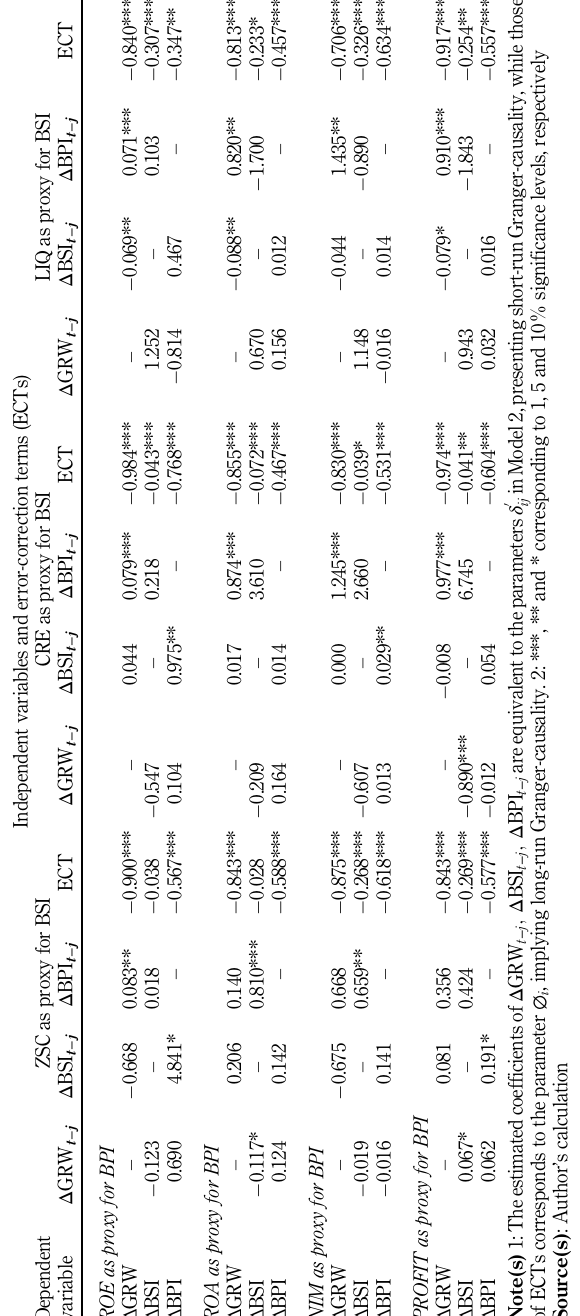
Table 3. Results of panel Granger-causality estimations from Model